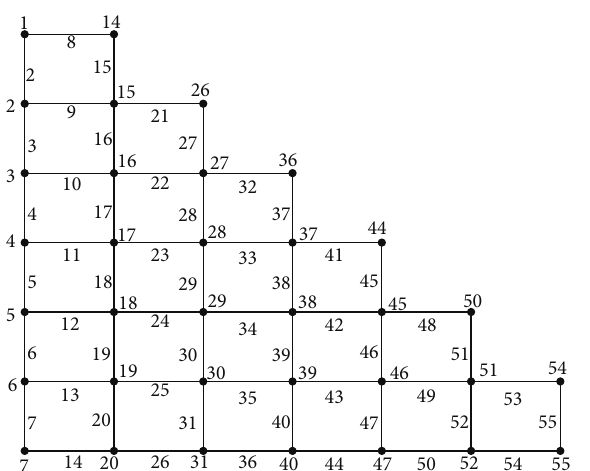
Figure 5: A C -exponential mean labeling of ST